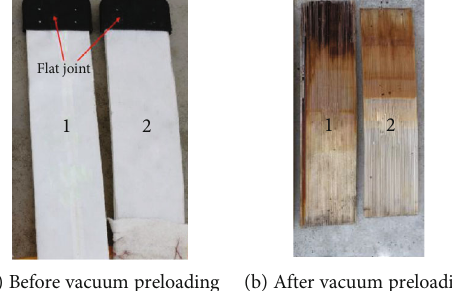
Figure 14: PVD before and after the test.